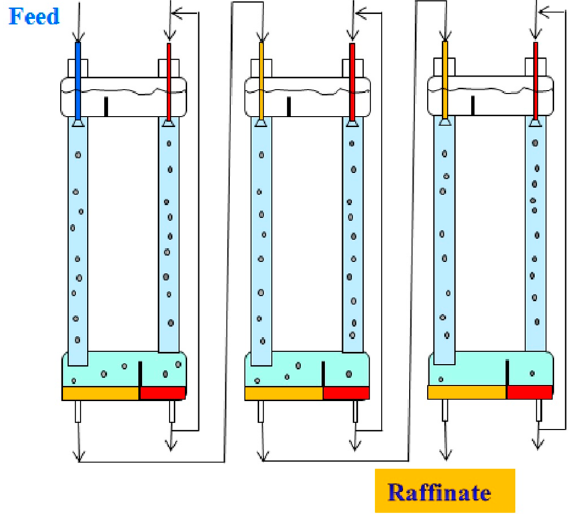
9 of 13 Figure 6. Schematic principles of the operation of the two-column three-phase extraction apparatus with forced circulation of the membrane phase and countercurrent fl ows of phases in both columns. Red arrows—circulation of the membrane phase; black arrows— fl ows of the aqueous phases. An increase in the degree of extraction of metals in two-column three-phase extrac- tion can be achieved using multistage processes that carry out the separation in a cascade of two-column extractors (Figure 7) or in multistage two-chamber columns (Figure 8). In